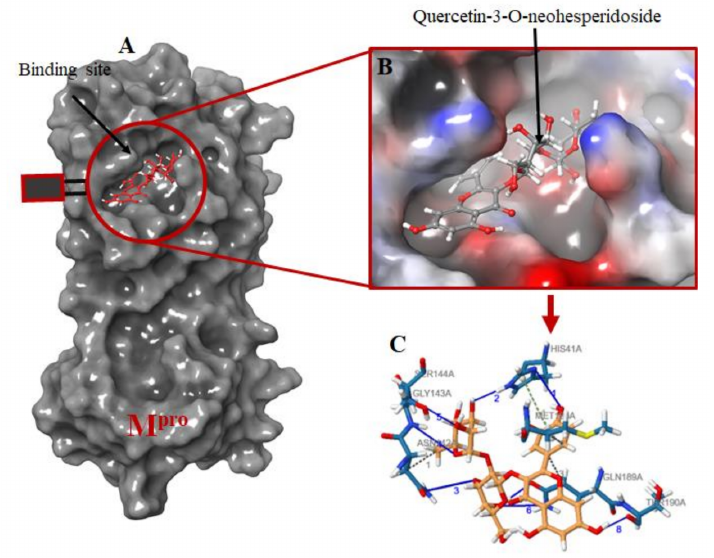
Figure 2. Molecular docking of the ligands into M pro binding site. ( A ) the docking of the selected ligands in M pro binding pocket; ( B ) Quercetin-3-O-Neohesperidoside seats perfectly in the Mpro binding pocket; ( C ) interacting atoms of Quercetin-3-O-Neohesperidoside and M pro residues in the binding pocket. Note: blue lines indicate hydrogen bond interaction; green dotted lines indicate pi-stacking, while gray dotted lines depict hydrophobic